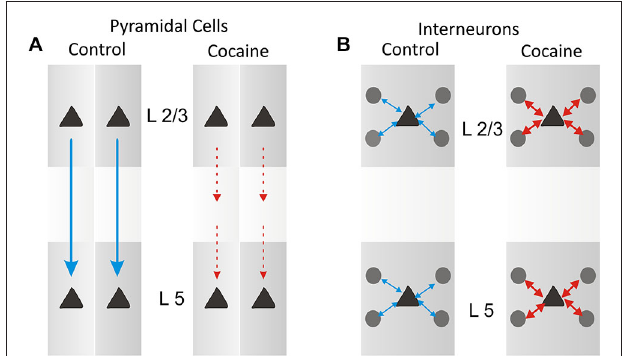
FIGURE 5 | Schematic diagram for columnar laminar microcircuit interactions illustrating possible underlying basis for the effects of cocaine administration which produced a partial uncoupling (A) of inter-laminar correlated firing between cells in PFC layer 2/3 and